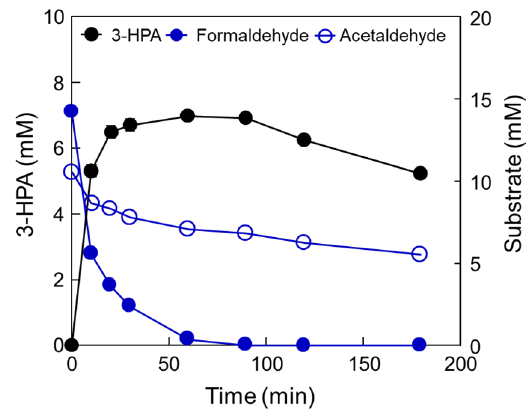
Figure 4. Production of 3-HPA from formaldehyde and acetaldehyde by DERA Tma under optimized conditions. Time-course reactions were performed in 20 mM Kpi buffer (pH 7.0) containing 1.66 U/mL enzyme with 15 mM formaldehyde and 10 mM acetaldehyde at 40 ◦ C for 180 min. Data represent the means of two separate experiments, and error bars represent the standard deviation.